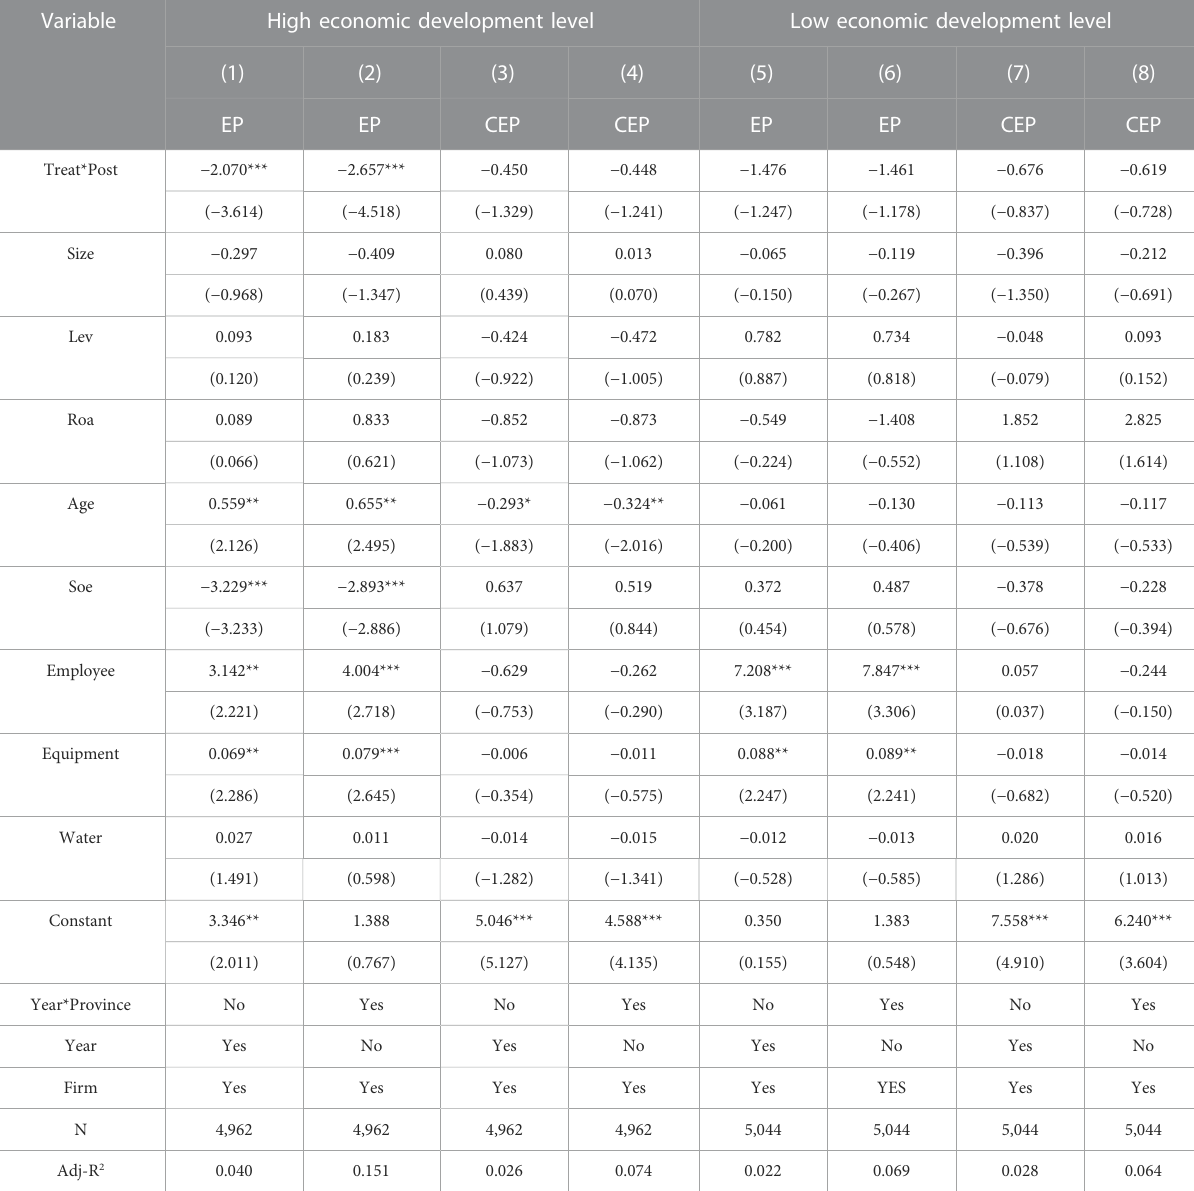
TABLE 6 NSMF program, economic development level, and corporate environmental performance.